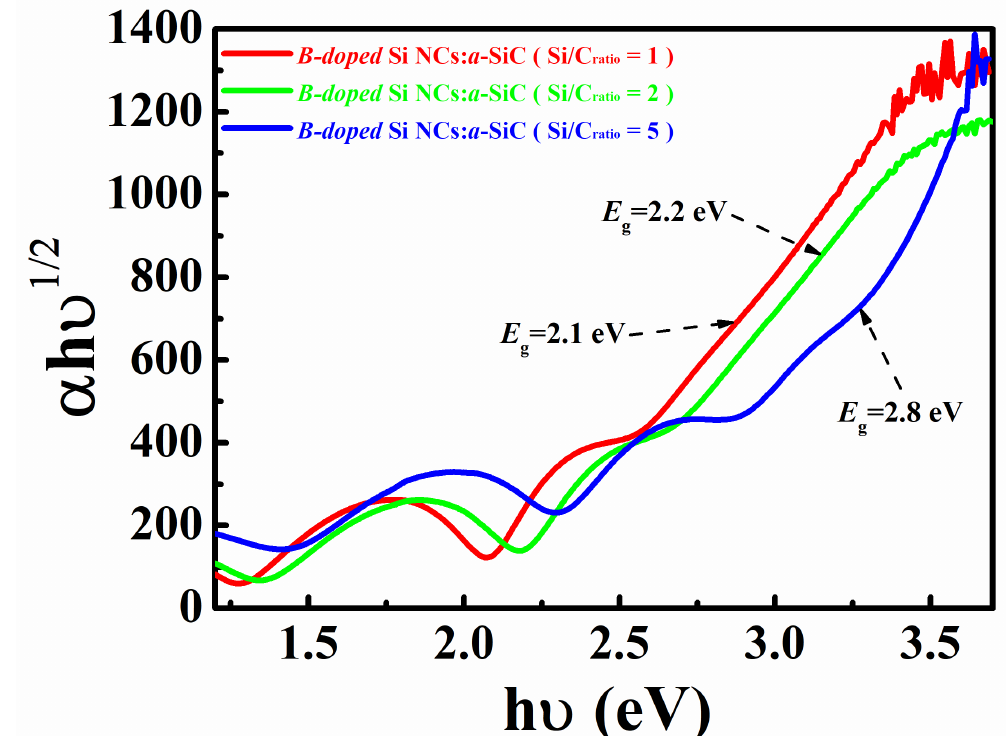
Figure 3. Tauc’s plots of ( α h υ ) 1⁄2 versus photon energy h υ for B-doped Si NCs: a -SiC films with various Si/C